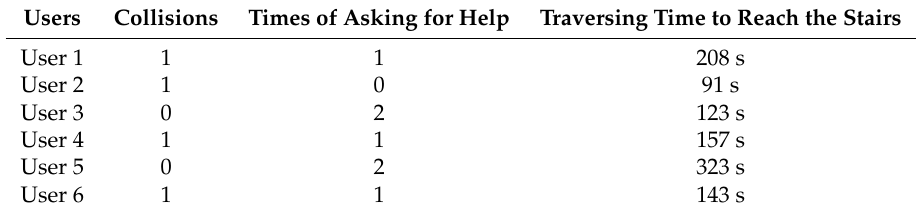
Table 6. Field test results.